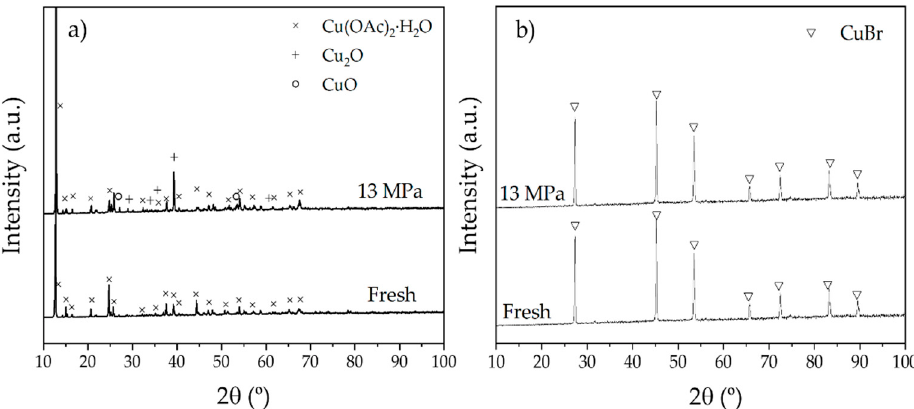
Figure 1. XRD spectra of fresh catalysts and after scCO 2 at 13 MPa and 35 ◦ C ( a ) Cu(CH 3 COO) 2 · H 2 O and ( b ) CuBr.